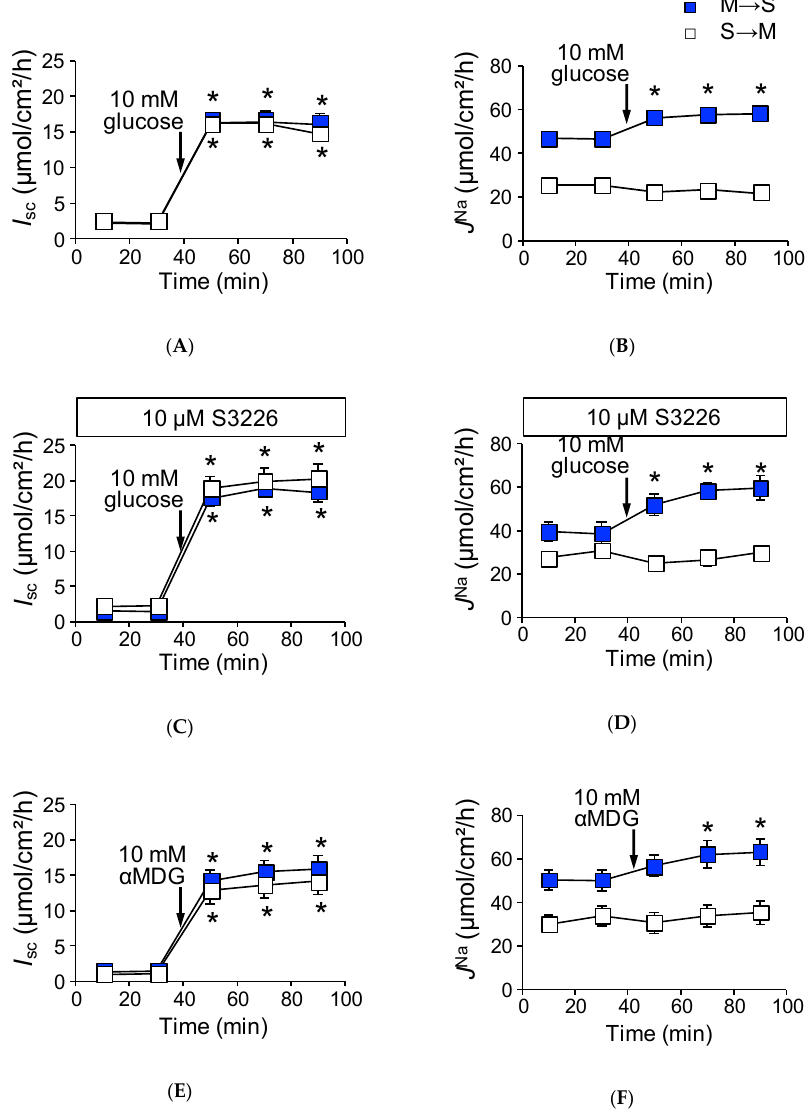
Figure 1. Activation of SGLT1 increases unidirectional mucosal to serosal 22 Na + fluxes under short-circuit conditions in wild-type mice: Glucose-induced short-circuit current changes ( I sc ) ( A ) and 22 Na + unidirectional flux changes ( J Na ) ( B ) were measured simultaneously in Ussing chambers, as described in the Materials and Methods. After measure basal I sc and J Na during the initial 30 min (squares represent mean of 9 and 8 measurements mucosal to serosal (M to S) and serosal to mucosal (S to M), respectively), glucose was added to the mucosal side, indicated by arrows ( n = 9 and 8, M to S and S to M, respectively). The e ff ects of S3226 on glucose-induced I sc ( C ), and J Na ( D ). Thirty minutes before initiation of measurement, 10 µ M S3226 was added to the mucosal side ( n = 5 and 5, M to S and S to M, respectively). Non-metabolizable sugar alpha methyl- d -glucose ( α MDG) increase of I sc ( E ) and J Na ( F ) ( n = 6 and 6, M to S and S to M, respectively). Closed squares indicate mucosal to serosal unidirectional 22 Na + fluxes ( J Na MS ) and open squares indicate mucosal to serosal 22 Na + fluxes ( J Na SM ). Each point represents the mean ± SE. Where error bars are absent, they are smaller than the symbol used. * p < 0.05 as compared with the baseline